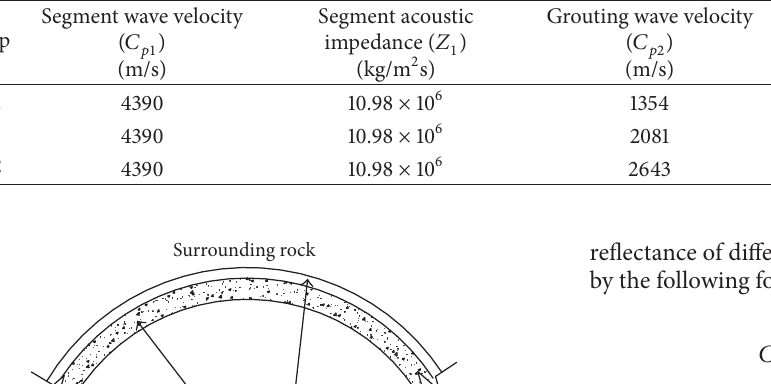
Table 2: Acoustic parameters of SG samples.